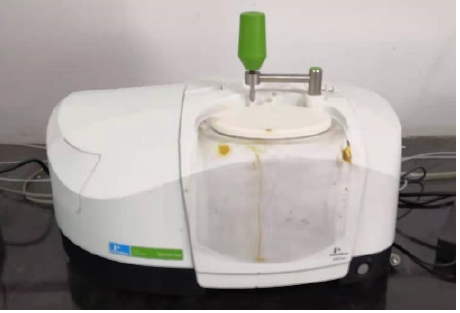
Figure 5. Fourier transform infrared spectrometer.